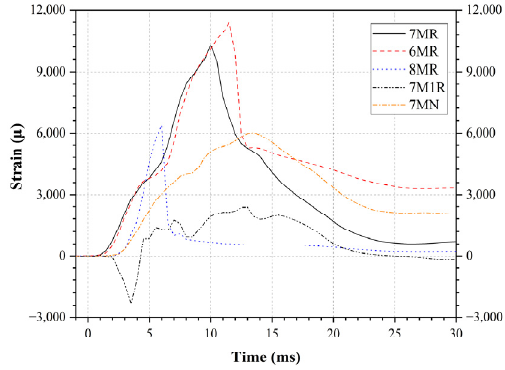
Figure 14. S1 steel strain under first impact.